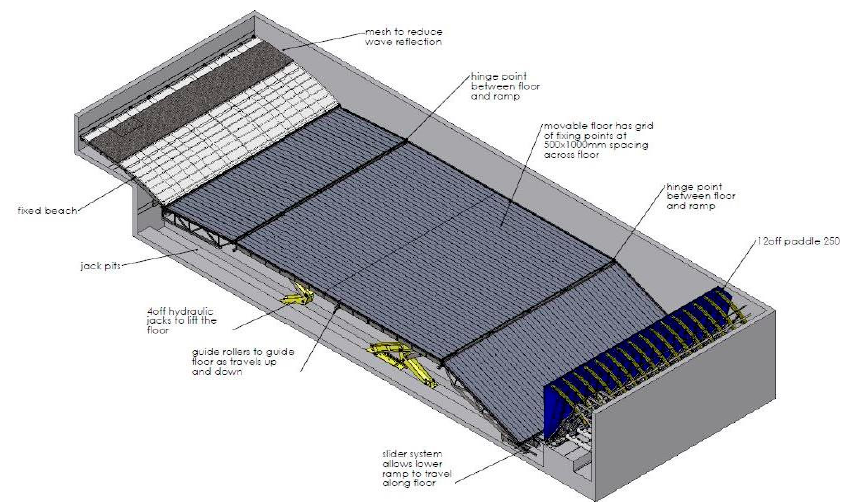
Figure 7. Deep Ocean Basin of the Lir National Ocean Test Facility.